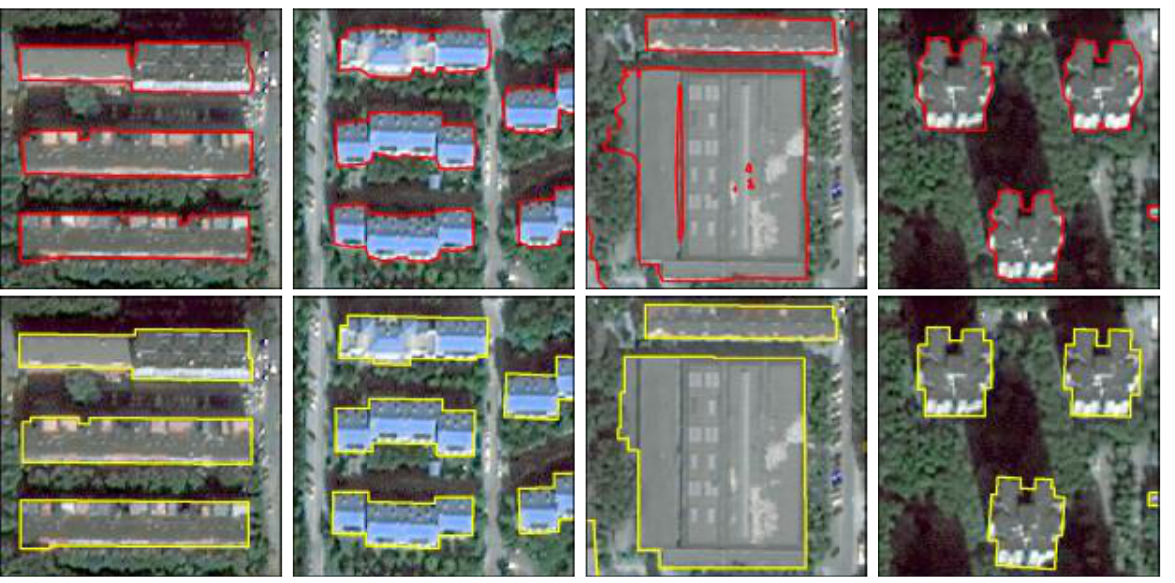
Figure 11. The vectorization result of building extraction. The first row is the vectorized result of the original prediction of the buildings; The second row is the results of the building after morpho- logical processing and regularization of the original building prediction results. Table 7. Accuracy of building prediction vector results.